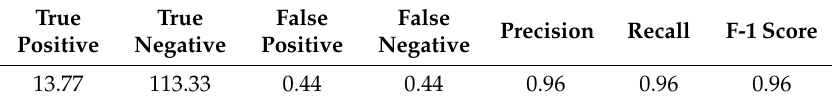
Table 4. False positive, false negative, precision, and recall of obfuscated